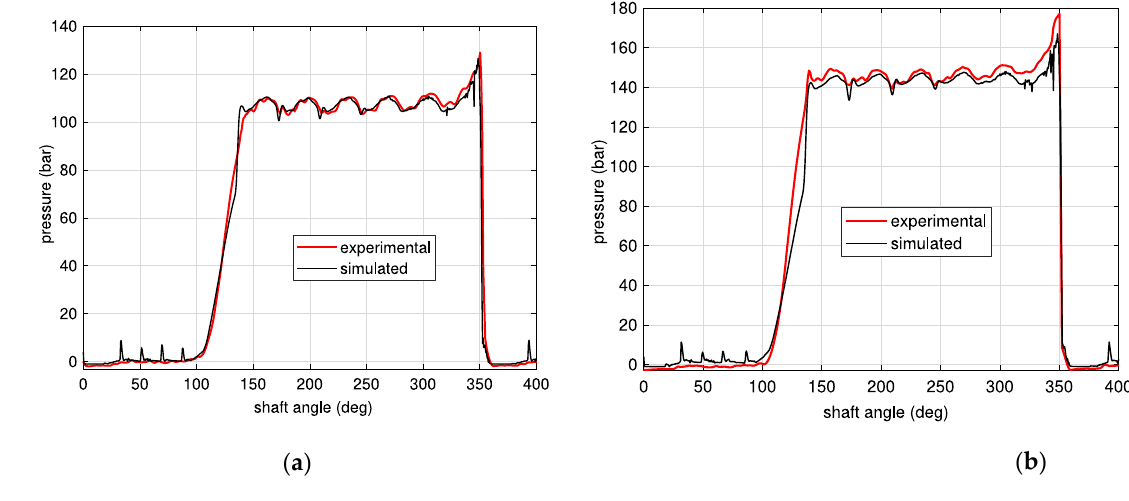
Figure 10. Chamber pressure with plates A at 1500 rpm ( a ) and at 1750 rpm ( b ).